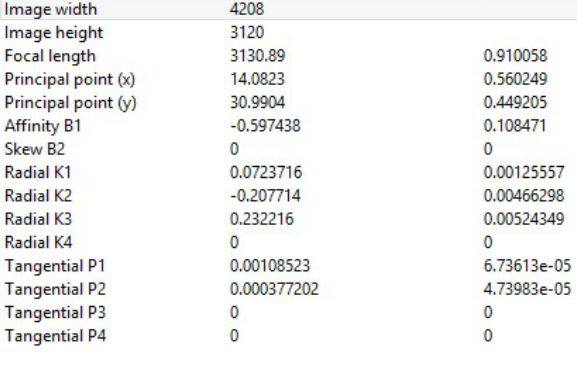
Figure 3. Calibration results